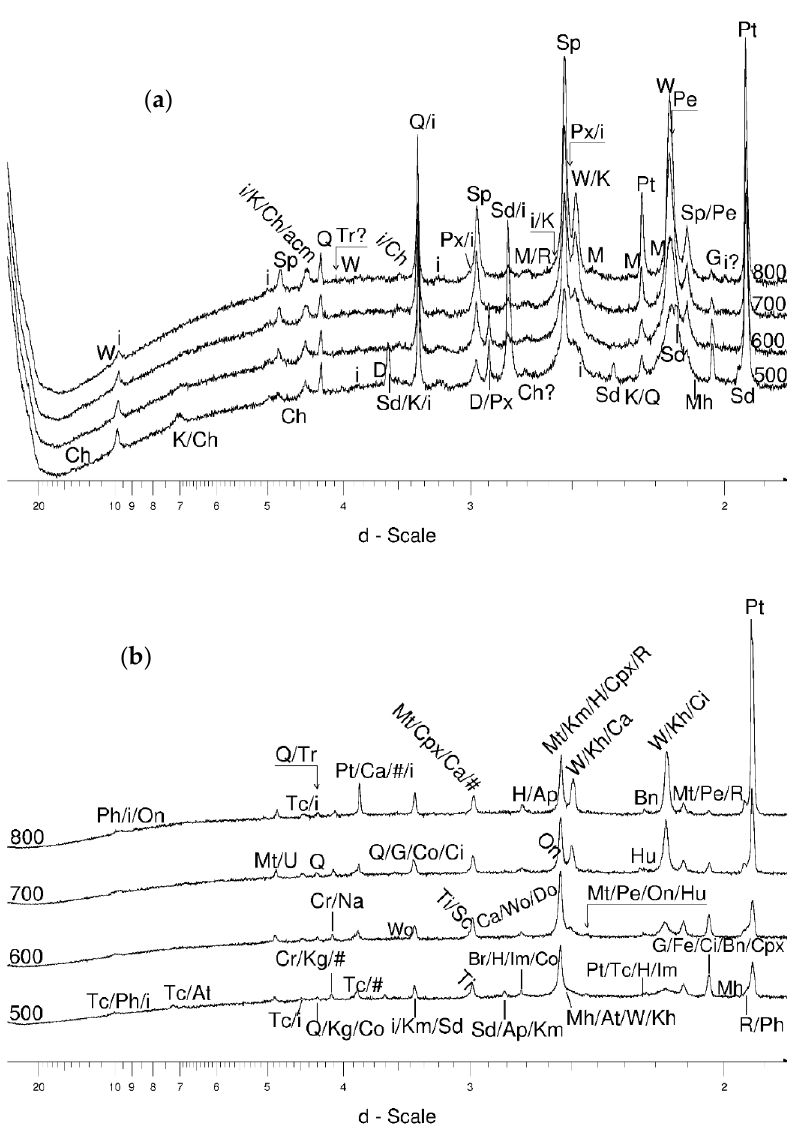
Figure 2. Results of heating (500–800 °C) two sideritic samples for comparison. ( a ) USCB sample. ( b ) LSCB sample. acm—(semi)amorphous post-clay matter, Bn—barringerite, Br—braunite, Co—calcio-